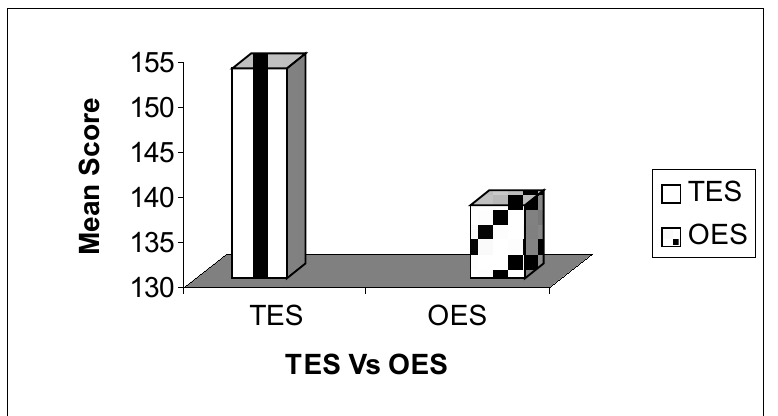
Figure 2 . Comparison of mean values (academic motivation) of students studying under TES and OES.